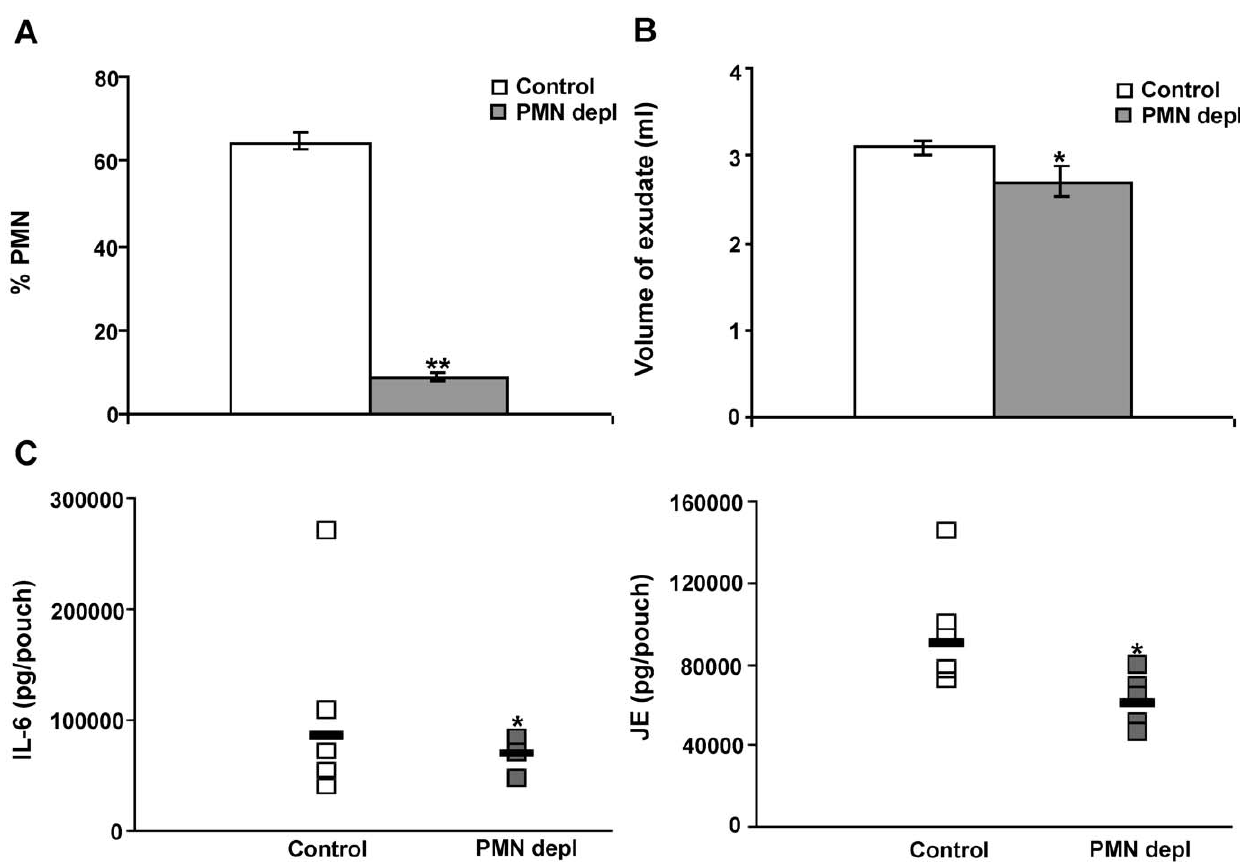
Figure 5. Neutrophil depletion leads to a reduction of the inflammatory response. wt mice with 6-day-old air pouches received an intraperitoneal injection of a LEAF TM purified anti-mouse Ly-6G/Ly-6C (Gr-1) antibody 18 h before carrageenan challenge. On day 7, 1 ml of 1% l - carrageenan was injected into the pouch cavity. Mice were sacrificed 4 h after l -carrageenan injection. (A) The percentage of PMN was quantified in 10 different 400 6 fields with inflammatory infiltrate. (B) The volume of exudate collected was quantified. Bars, mean 6 SEM, n=5 2 7 mice/group. (C) The levels of mouse IL-6 and JE in the air pouch lavage were determined using a multiplexed ELISA array. Data represent geometric mean, n=4 2 5 mice/group. *indicates p , 0.05; **indicates p , 0.001.